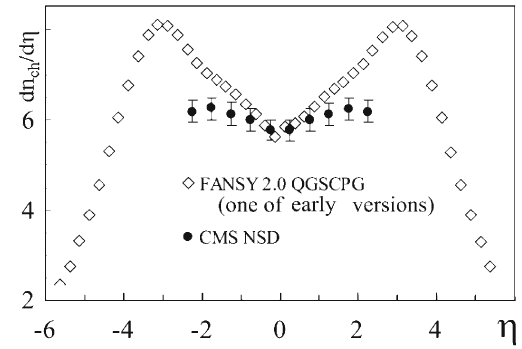
Fig. 1 Peaks in d σ/ d η distribution originated by growth of transverse momenta of most energetic particles in high- p copl t -concept CPG ver- sions